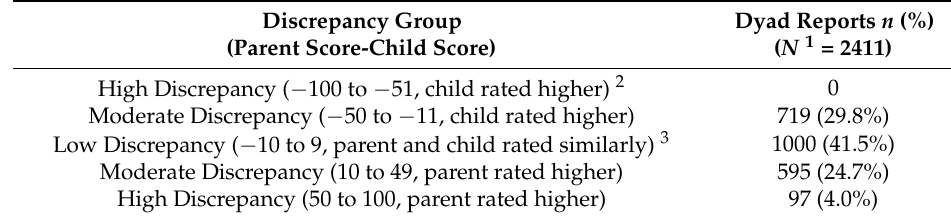
Table 2. Groups of Fatigue Score Discrepancy.